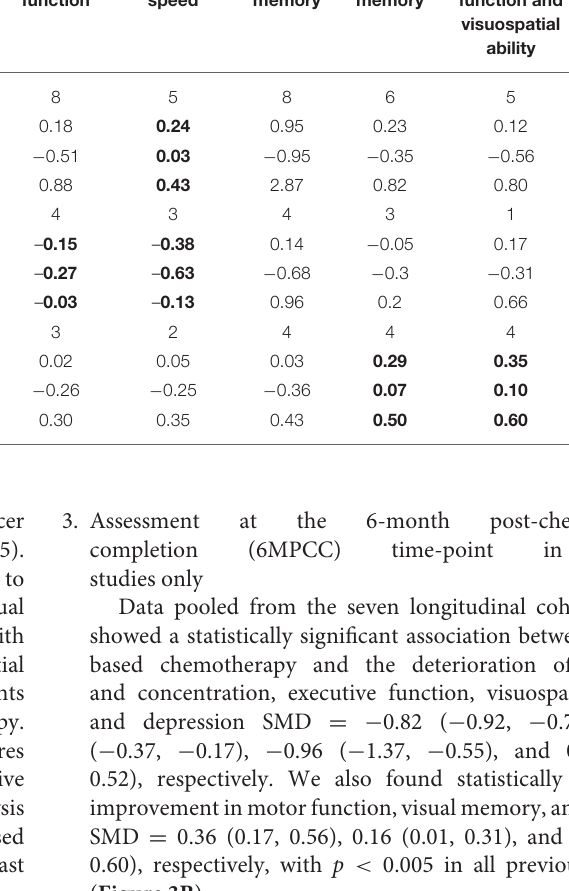
TABLE 5 | Results from random-effect meta-analysis for cognitive domain by comparison method (in bold p < 0.005).